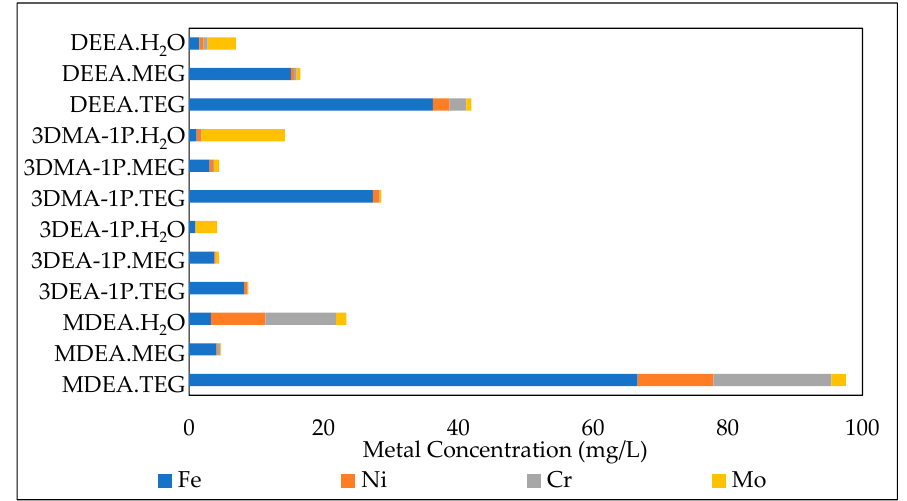
Figure 13. Metal concentrations of amine solutions after five weeks; unloaded amine wt.% = 30; CO 2 loading ≈